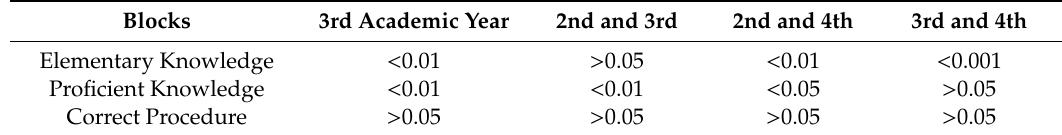
Table 3. Relationship between knowledge and correct procedure according to each academic